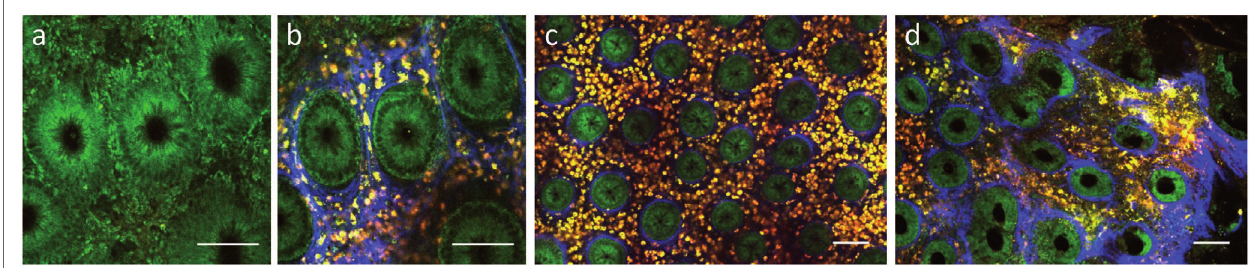
FiGURe 3 | Label-free multiphoton microscopy of Crohn’s disease in human colon biopsies. (a) Epithelial layer at 10 µm depth. (b) Upper lamina propria at 40 µm depth. (c) Weak inflammation. (d) Strong active inflammation. Scale bars: 100